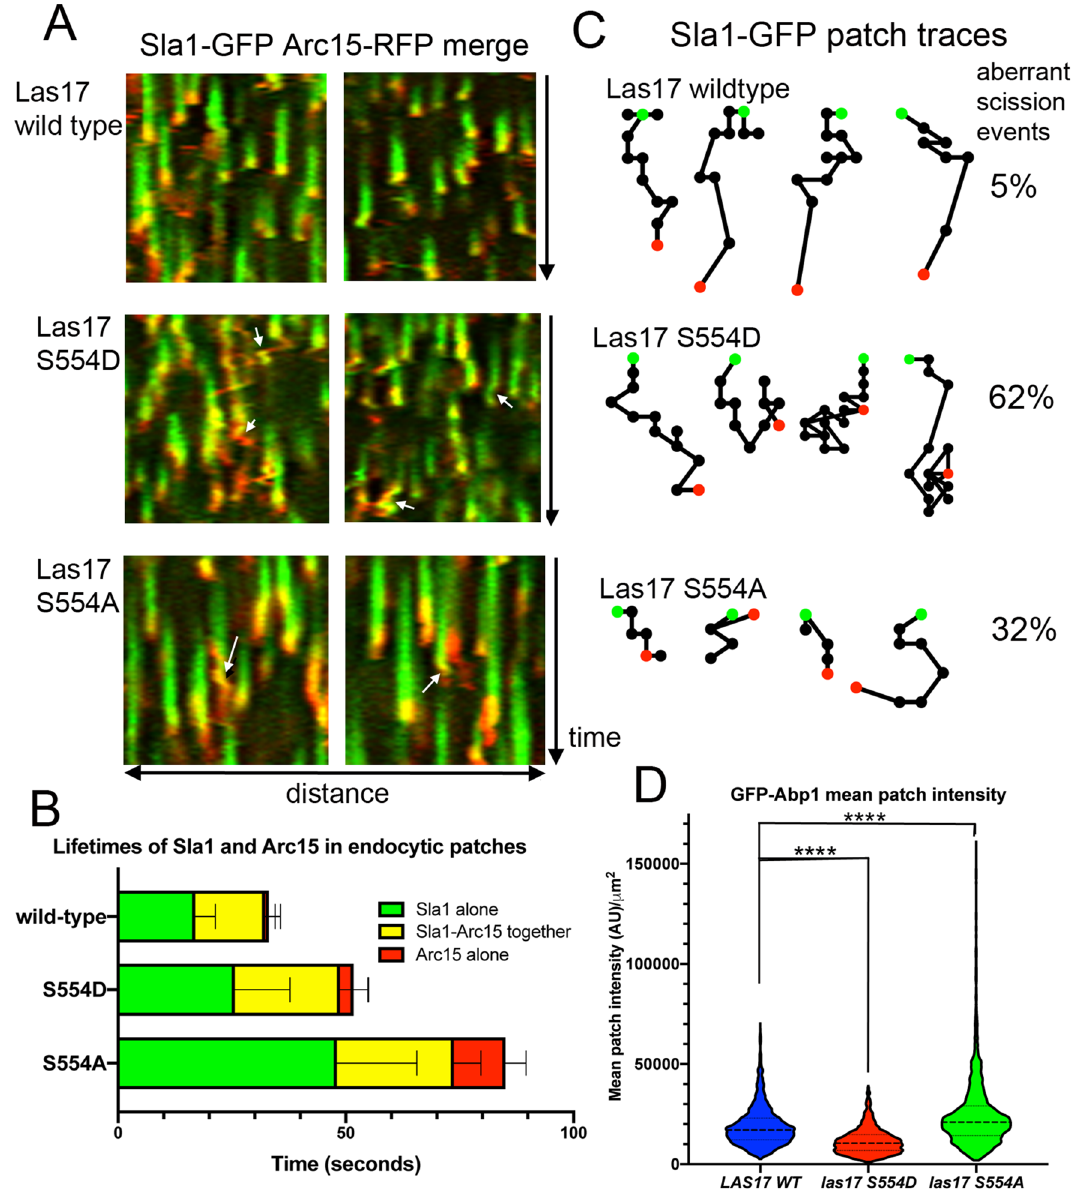
Figure 4. The effect of Las17S554 mutations on individual endocytic events. ( A ) Representative kymographs from the bud circumference of cells expressing wild-type or Las17S554A/D mutants tagged with Sla1-GFP (green) and Arc15 (red). As individual kymographs are from endocytic patches whole surface of the cell invaginations are shown by movement in either direction on the x axis, and retractions are characterised by a subsequent change in direction on the x axis. Arrows indicate retraction events. ( B ) Lifetimes of Sla1 and Arc15 labelled patches in wild type and mutant cells. Green indicates time of only Sla1-GFP in the patch; yellow when both Sla1 and Arc15 are present and red the time when only Arc15 is observed. Error bars show standard deviation for each lifetime. Sla1-GFP and Arc15-ChFP patch lifetimes are significantly different for both mutants compared with the wild-type judged by one way ANOVA with Dunnetts multiple comparison test ( p < 0.0001) ( C ) Patch tracking was also used to analyse the behavior of individual endocytic patches labelled with Sla1-GFP. Green dots represent the start of tracks and are on the membrane, red dots represent the ends of tracks. Movement in the plane of the membrane is represented on the x axis, y axis represents movement perpendicular to the plane of the membrane. The proportion of events measured from movies where retraction is observed are noted to the right of the images. n = 76 wt; n = 58 S554D; n = 60 S554A. ( D ) GFP-Abp1 was used to determine whether there was an overall impact of the mutations on the level of F-actin at endocytic sites over their lifetime. Dotted line shows mean; violin plots shows total distribution of intensity data. One way ANOVA with Dunnetts test indicates the S554D mutant causes a significantly lower recruitment of GFP-Abp1 while the S554A mutant causes a significant increase in GFP-Abp1 at individual endocytic sites ( p < 0.0001 denoted